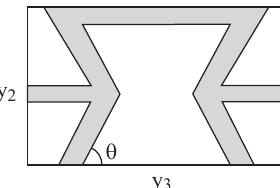
and ν ∗ with θ for a material with 23 32